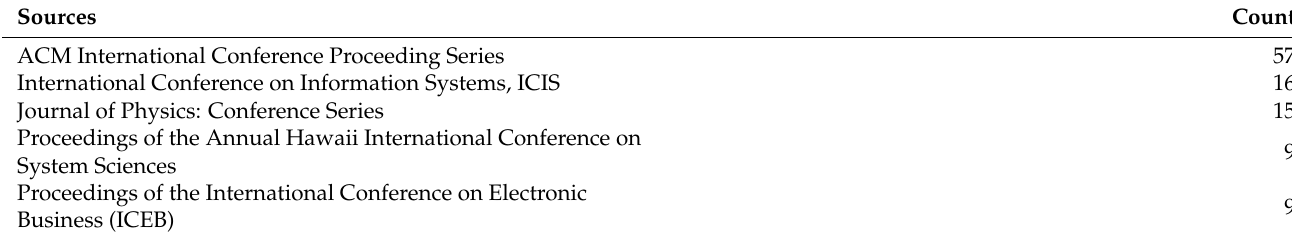
Table 2. List of conferences and